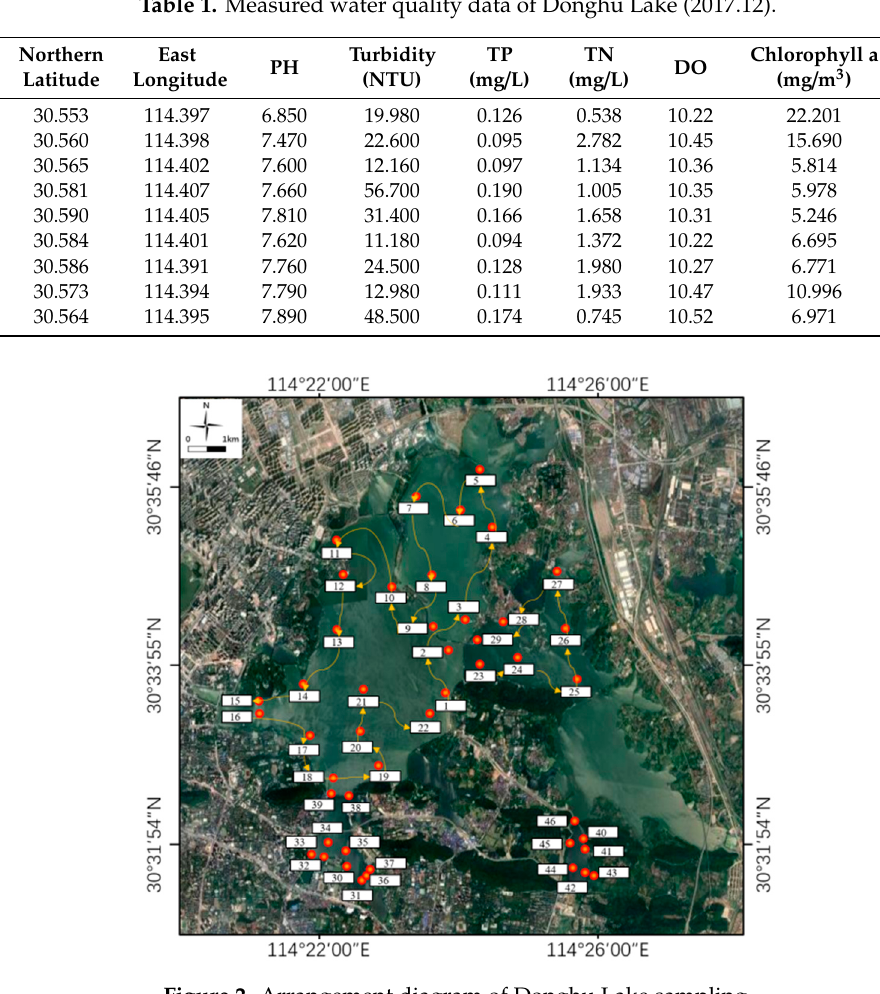
Figure 2. Arrangement diagram of Donghu Lake sampling.